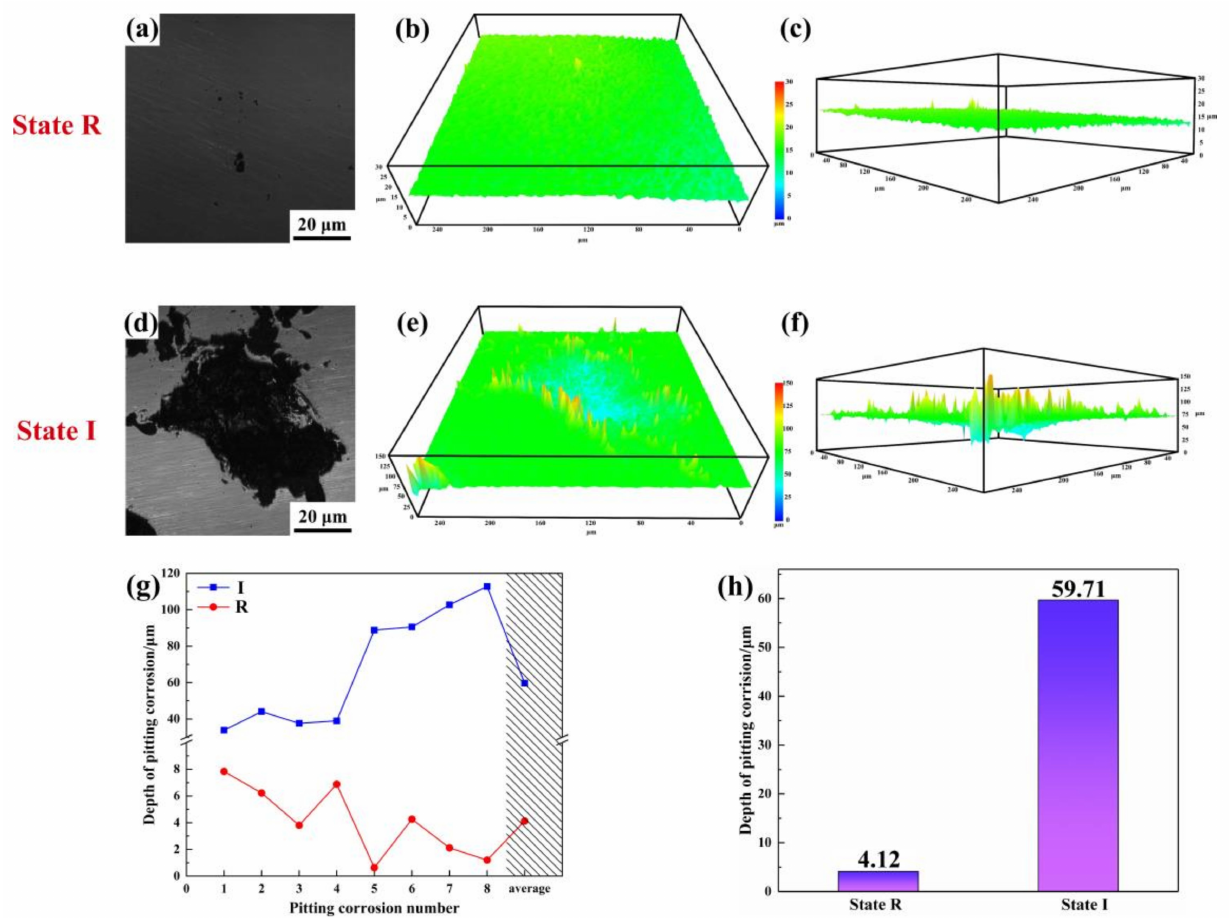
Figure 8. Three-dimensional morphologies of the corrosion pits in state R ( a – c ) and state I ( d – f ) and depth of corrosion pits ( g , h